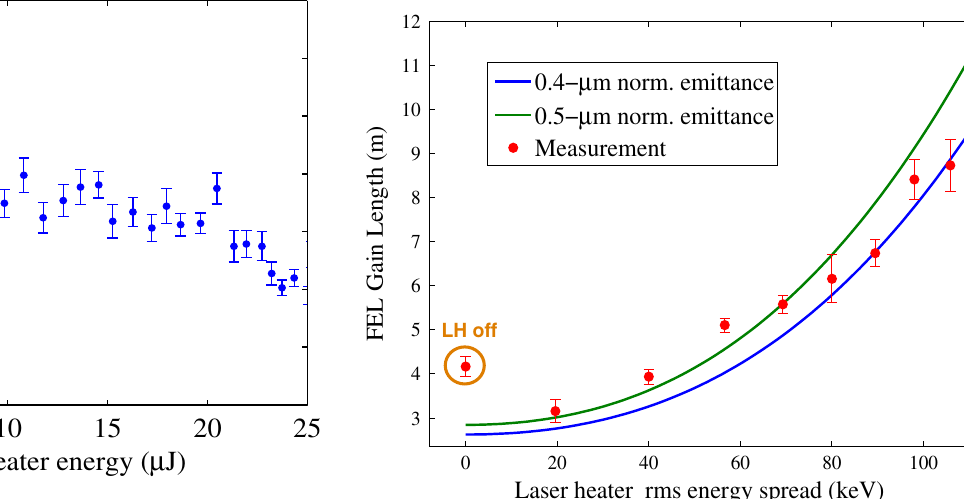
FIG. 15. (Color) FEL intensity at 1.5 A˚ measured on a down- stream YAG screen vs LH energy when 12 undulator sections are inserted.